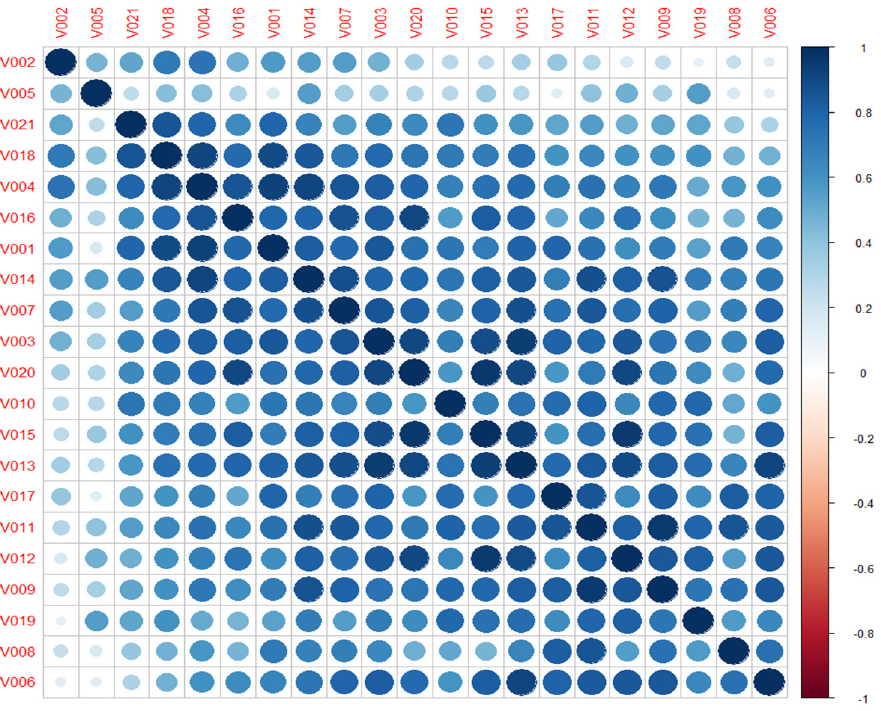
Figure 9. Correlation matrix between volunteers considering continuous reporting